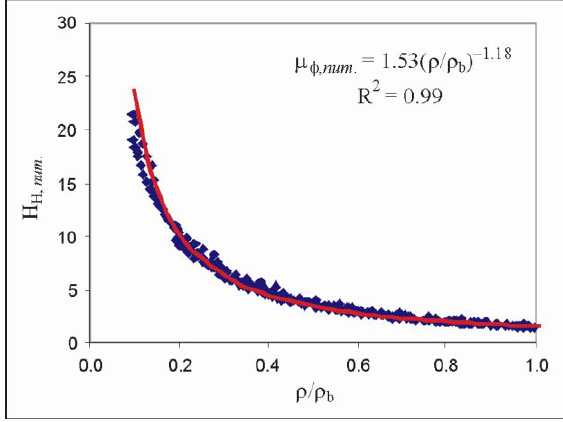
Fig. 2. Influence of b  / on the curvature ductility